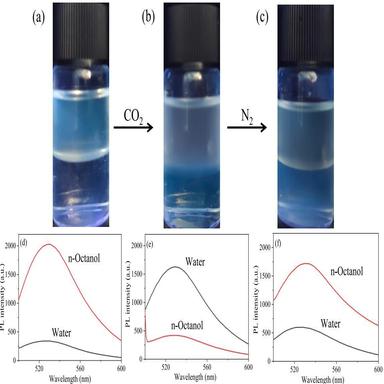
Photographs of CO2-responsive phase transfer materials (PEG-200) taken under UV light, in a n-octanol/water phase: before bubbling CO2 (a) and (d), after bubbling CO2 (b) and (e), and after removal of CO2 (c) and (f); the upper layer in the small bottle was n-octanol and the lower layer was water. The red curves represented the PL spectrum of CO2-responsive phase transfer materials (PEG-200) in n-octanol phase and the black curves represented the spectrum in the aqueous phase.